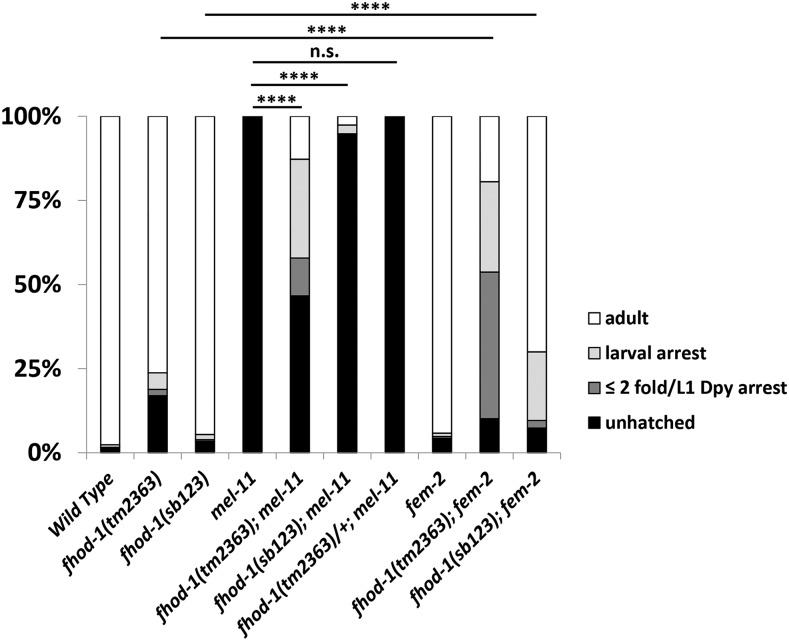
fhod-1(sb123), which encodes only the short isoform, has little effect on elongation in mel-11 or fem-2 backgrounds. Indicated genotypes were scored for growth to the indicated stages as described in MATERIALS and METHODS. While the fhod-1(tm2363) null allele rescues mel-11 lethality at 20°C, sb123 does so weakly and tm2363/+ does not at all. **** = P < 0.0001 and P > 0.99 respectively, by One Way ANOVA of hatching rates. Likewise, at 25° tm2363 enhances fem-2 elongation defects, while effects of sb123 are milder. **** = P < 0.0001 by One Way ANOVA of growth to L4/adulthood.